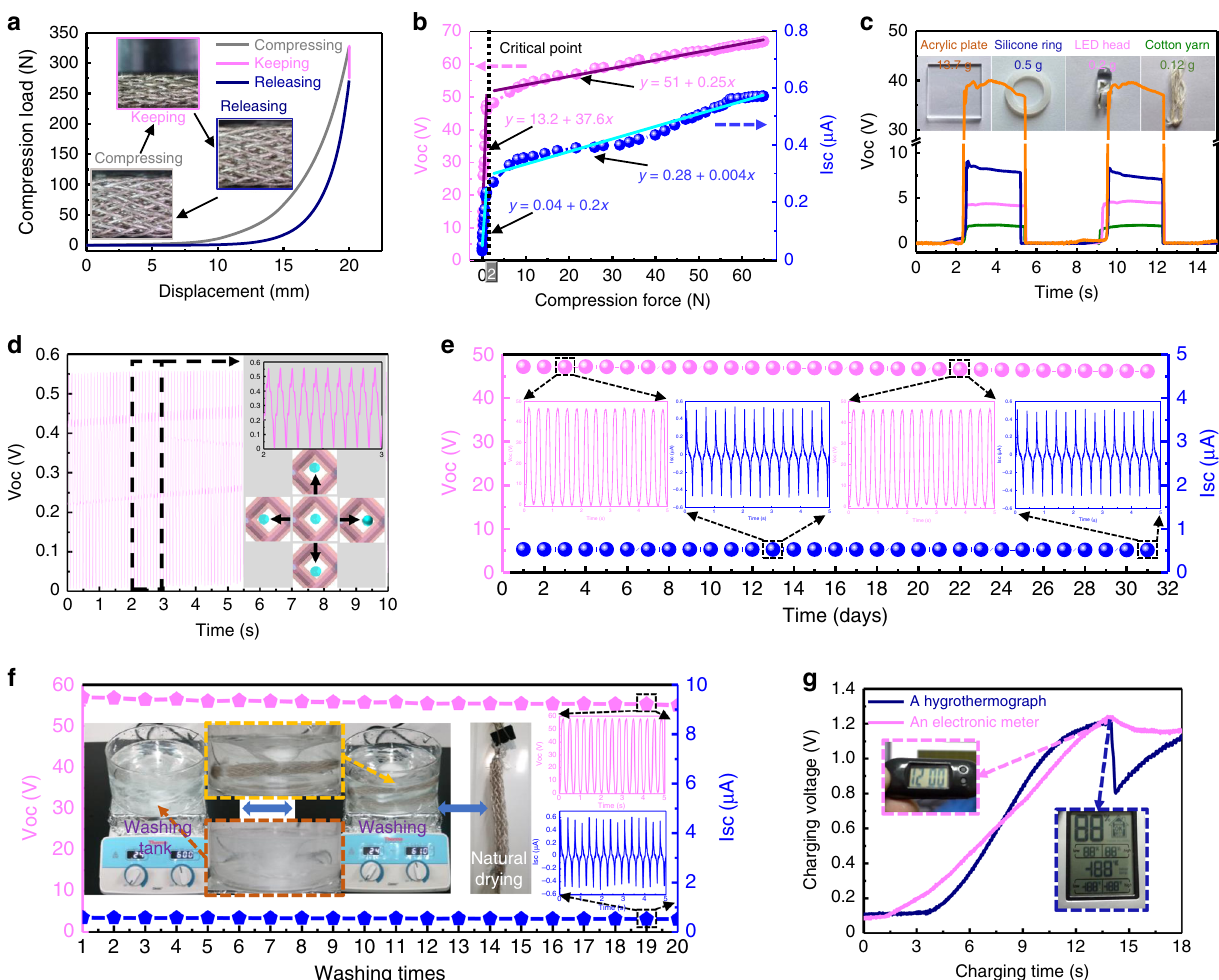
Fig. 4 Pressure sensitivity, long-term stability, and washability of the 3DB-TENG. a Load-displacement curve of the 3DB-TENG in the process of compression, retention, and release. b Variations of V OC and I SC of the 3DB-TENG as a function of applied forces. c Pressure sensitivity of the 3DB-TENG to different objects. d Vibrational energy harvesting ability of the 3DB-TENG under a vibrational frequency of 10 Hz. The images inserted at the top and bottom are the enlarged V OC output and the vibrational energy harvesting principle, respectively. e Analyses of the stability and durability of the 3DB-TENG by continuous test for nearly one month. f Analysis of the washability of the 3DB-TENG after 20 times washing. The inserted photos are the cultivated domestic washing environment. g Charging voltage curves of the 3DB-TENG in the process of powering electronic devices. The inserts are the photos of electronic devices under the operational state. Source data are provided as a Source data fi